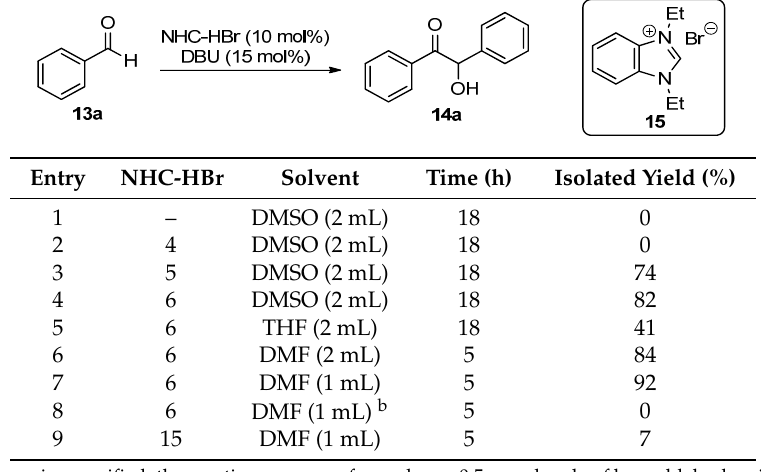
Table 1. Benzoin condensation reaction of 13a using polymers 4 – 6 and 15 a .